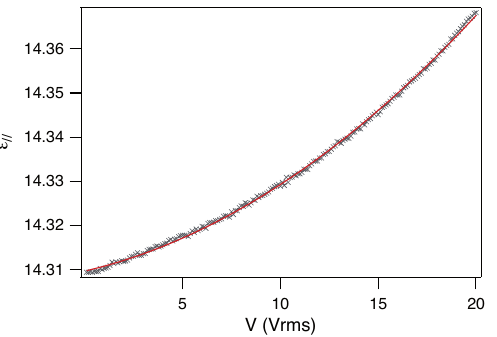
Figure 1. Dielectric constant ε (cid:107) measured in a homeotropic sample as a function of the applied voltage. The crosses are experimental points and the solid line is the best fit to a parabola. T = 35 ◦ C.